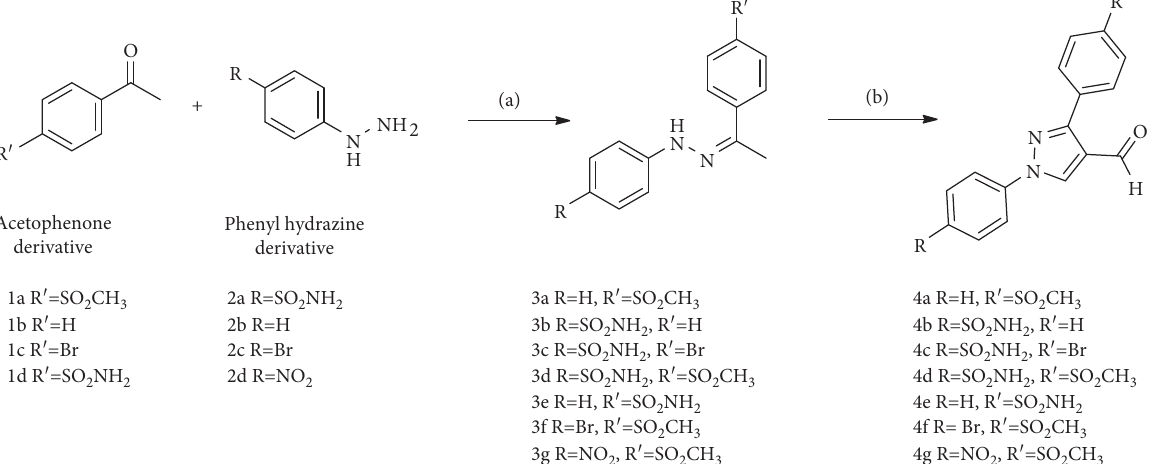
Scheme 1: Synthesis of pyrazole derivatives (4a–4g) . Reagents and conditions: (a) acetic acid, ethanol, and reflux; (b) dimethyl formamide, POCl 3 , and reflux.